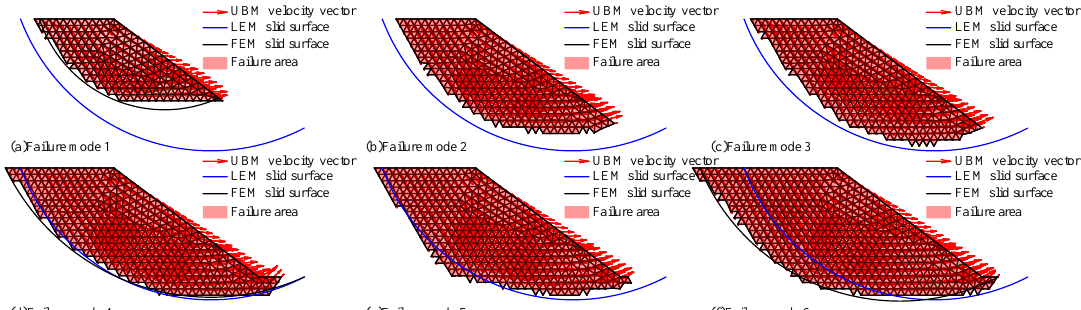
Figure 11. Histogram of k ( t m ) , k γ ( t m ) and k m ( t m ) of heterogeneous slope. F